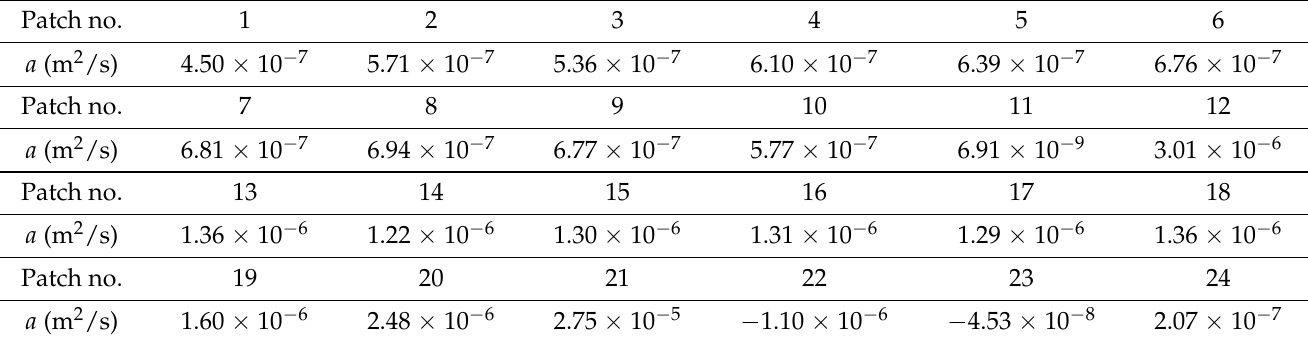
Table 1. Thermal diffusivity obtained for 9 August 2019.